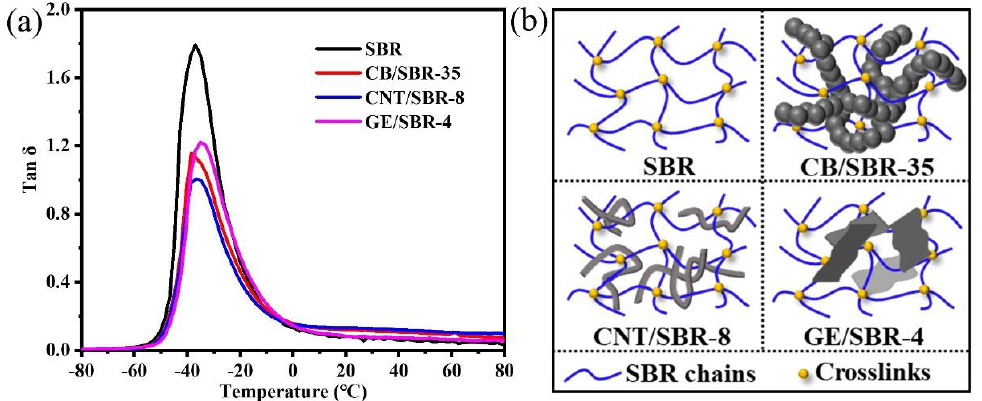
Figure 6. ( a ) Loss factor (tan δ ) versus temperature of and ( b ) schematic diagram of the filler networks of SBR, CB / SBR-35, CNTs / SBR-8, and GE / SBR-4 composites.